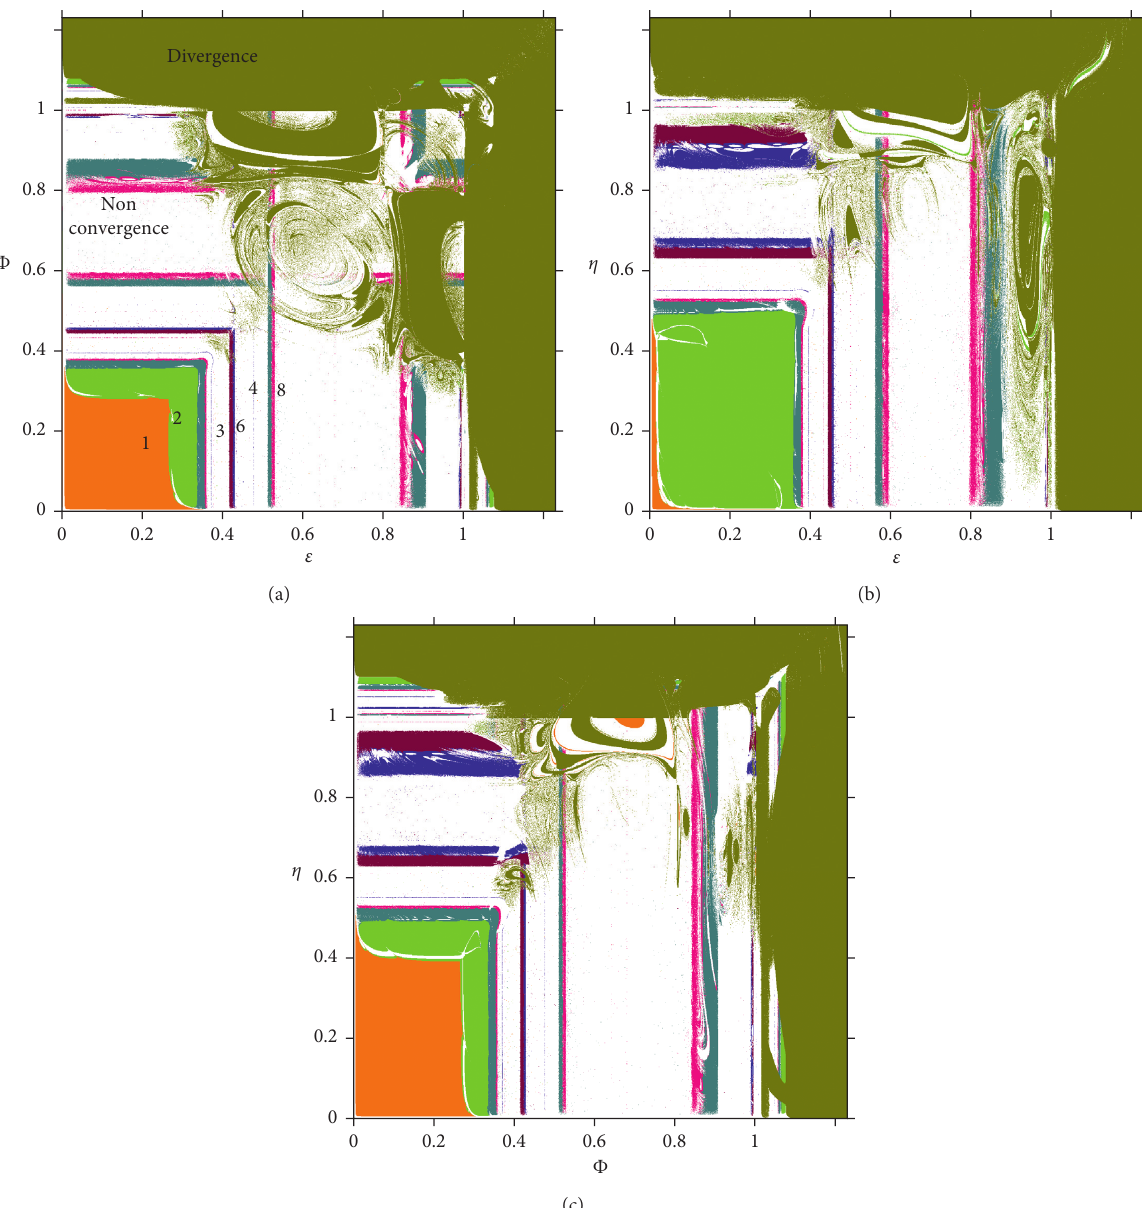
Figure 7: The basin of parameter. (a) The basin of ε and ϕ . (b) The basin of ε and η . (c) The basin of ϕ and η